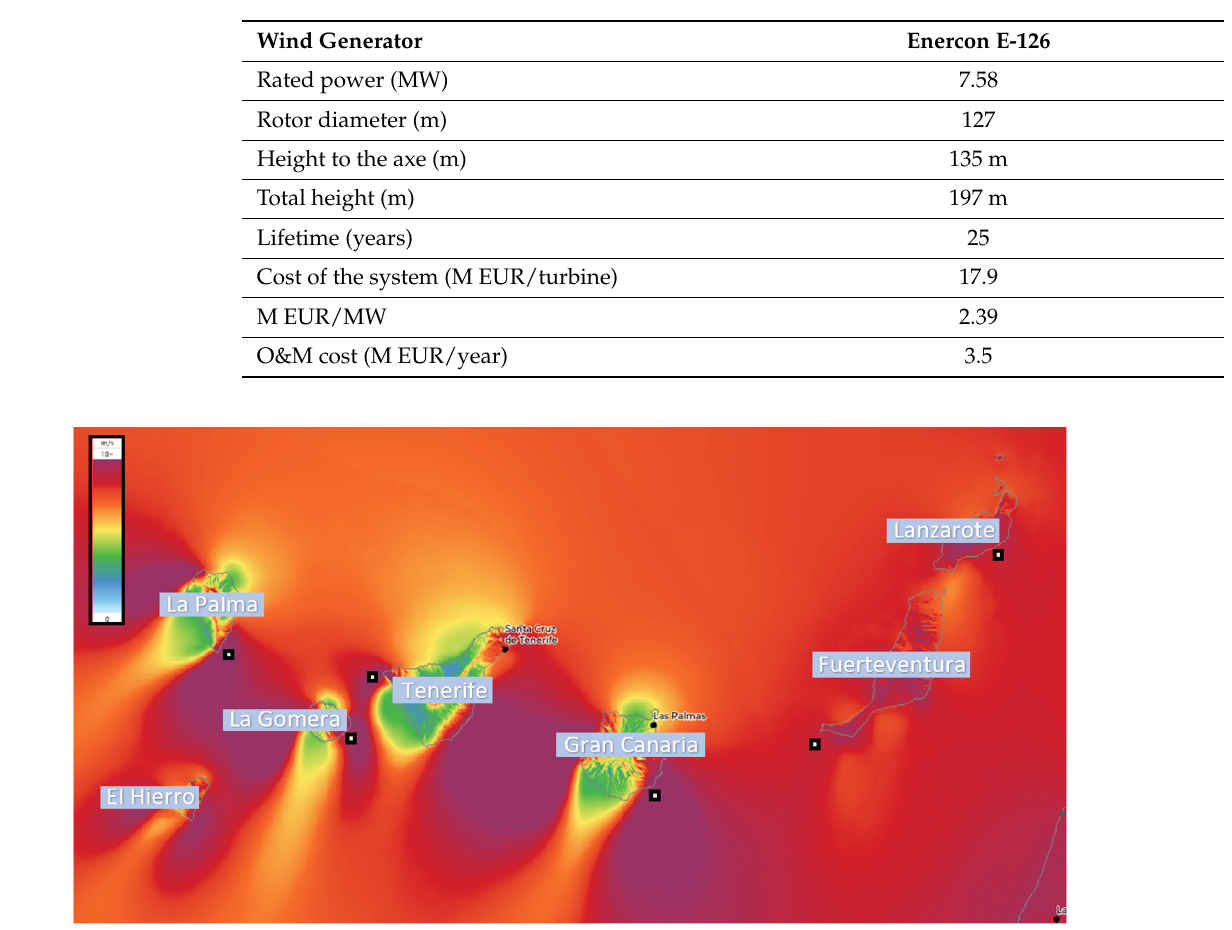
Figure 9. The offshore wind resource and optimum wind farm sites in the Canary Islands [49].